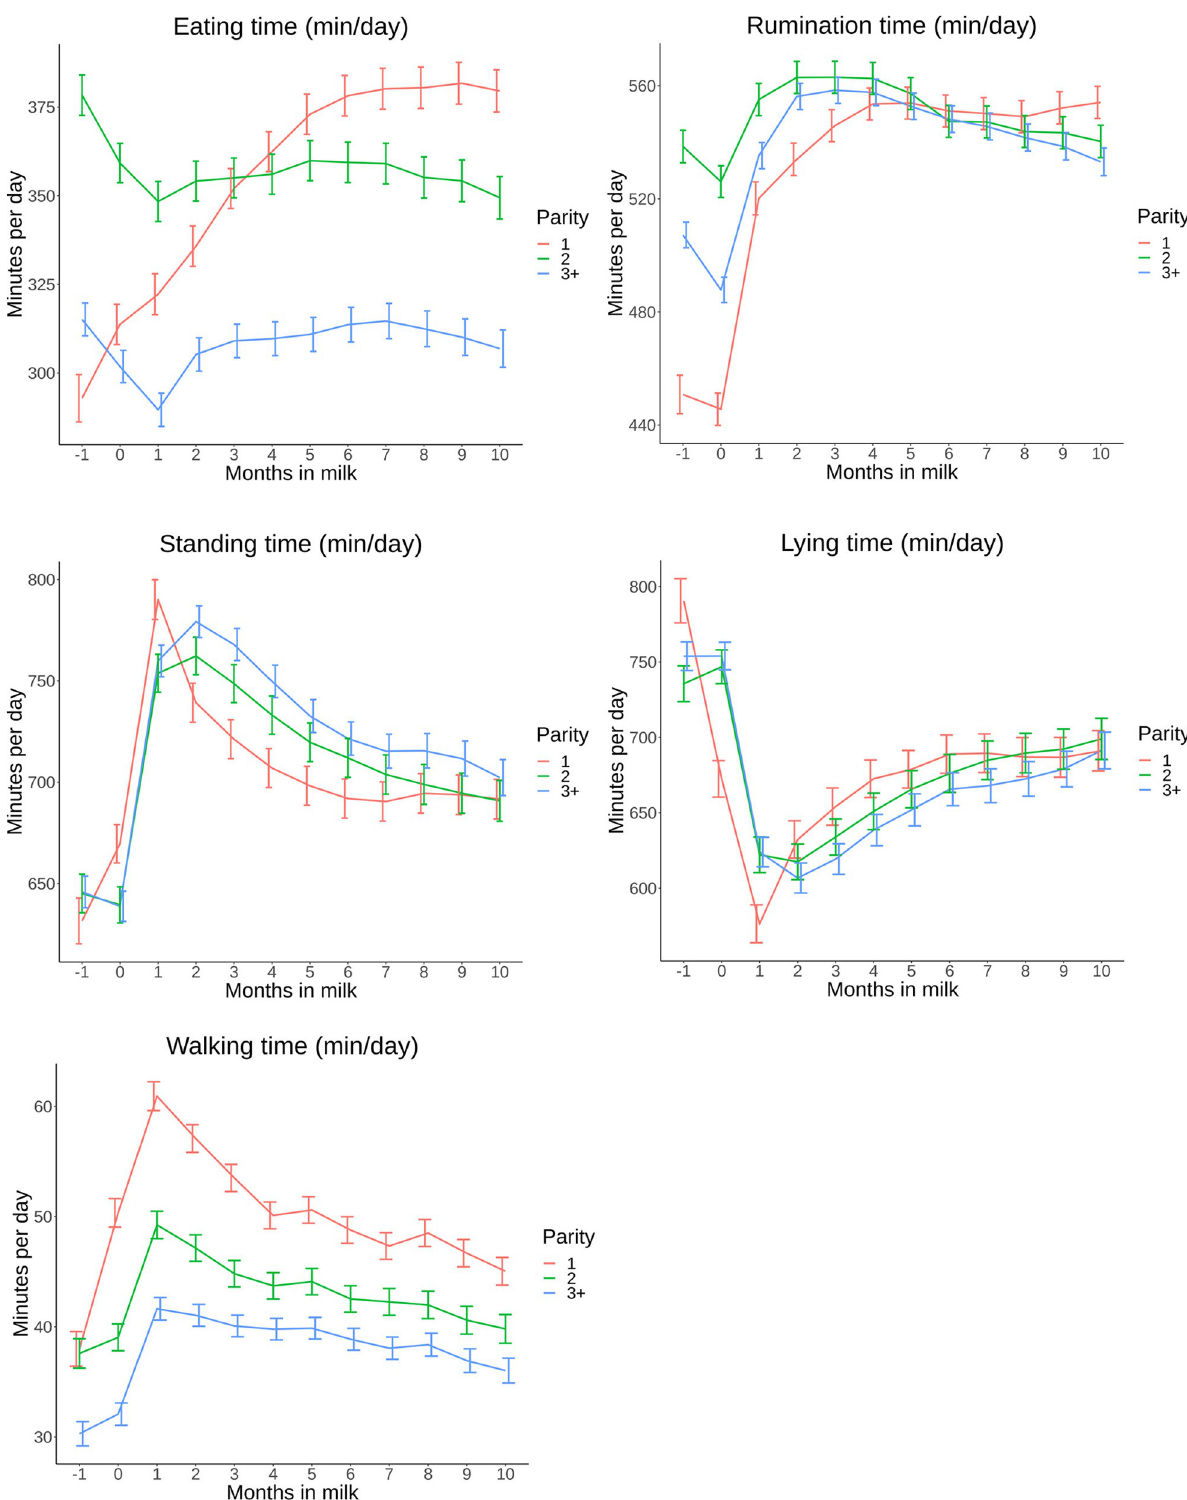
Fig 3. A,B,C,D,E: Time budget parameters in minutes per day (min/day) based on least square means (LSM) with 95% confidence intervals (95% CI) grouped by parity (1, 2 and 3+) on 8 commercial dairy farms in The Netherlands from 1 month before calving until 10 months in milk with “month 0” consisting of d-1, d0 and